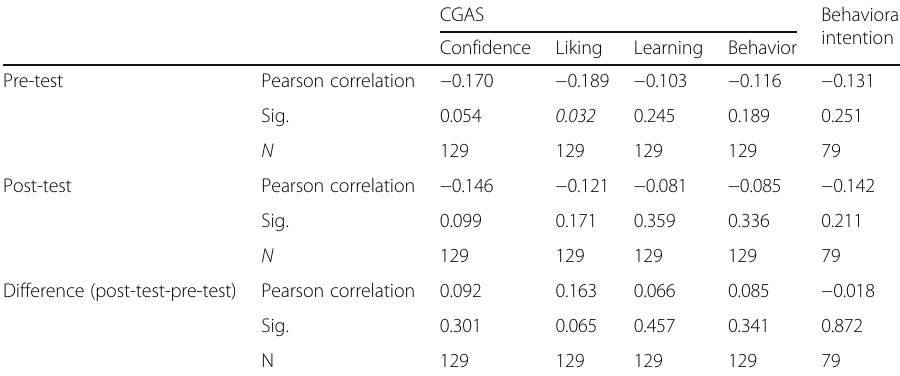
Table 12 Correlation analysis between students ’ academic achievements and CGAS factors as well as Behavioral Intention